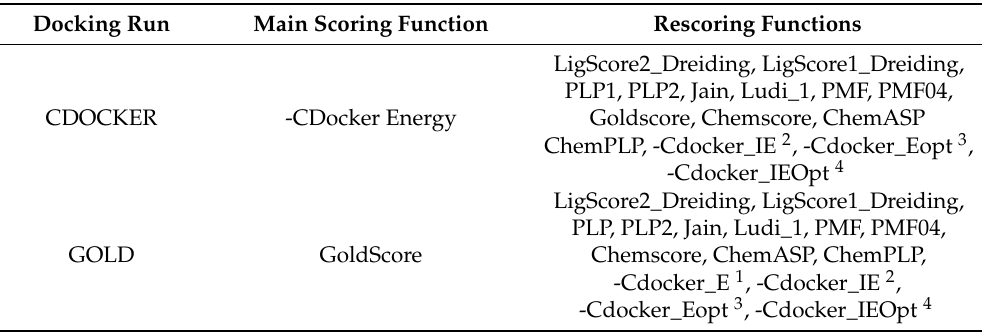
Table 9. Docking runs performed and Scoring functions.